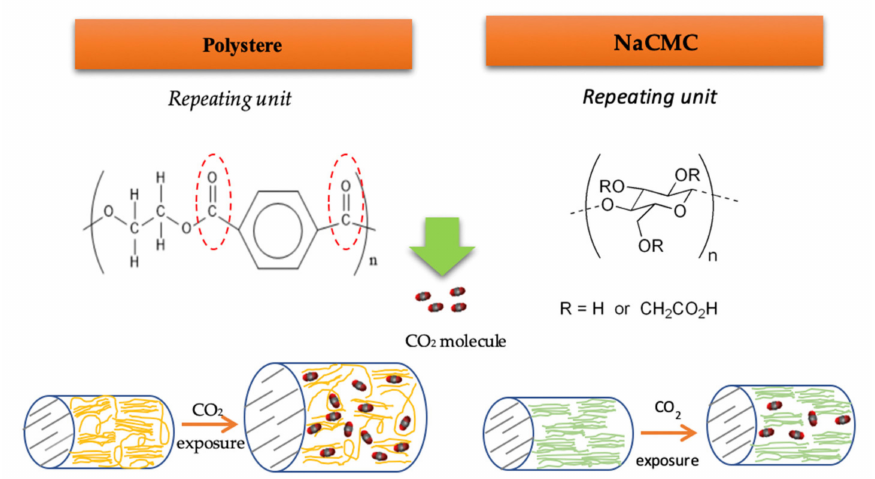
Figure 5. Simplified representation of the chemical structures and the swelling mechanism in PD and NaCMC dressings when subjected to scCO 2